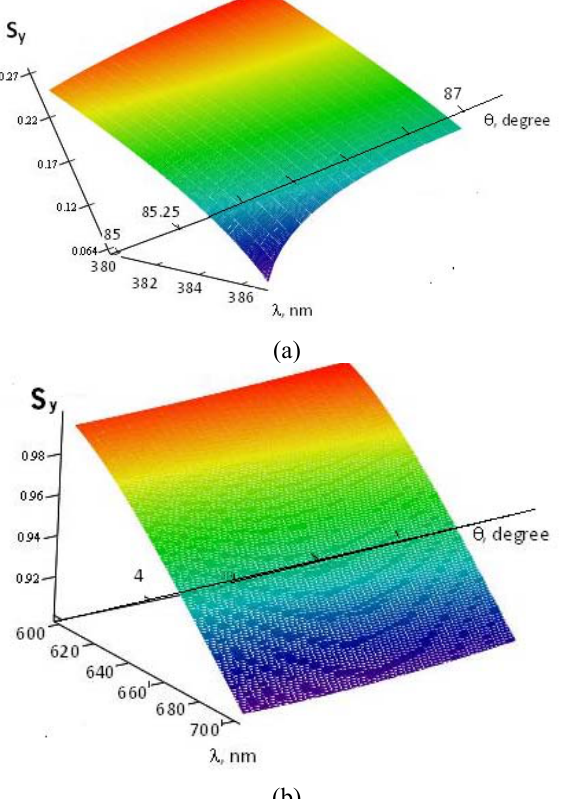
Figure 9: Expected value of transverse spin (in ħ units per photon) for the plasmon-polariton localized at the interface of a dielectric (fused quartz) and hyperbolic metamaterial of the I type (a) and II type (b). Hyperbolic metamaterial is formed from the multilayered Ti